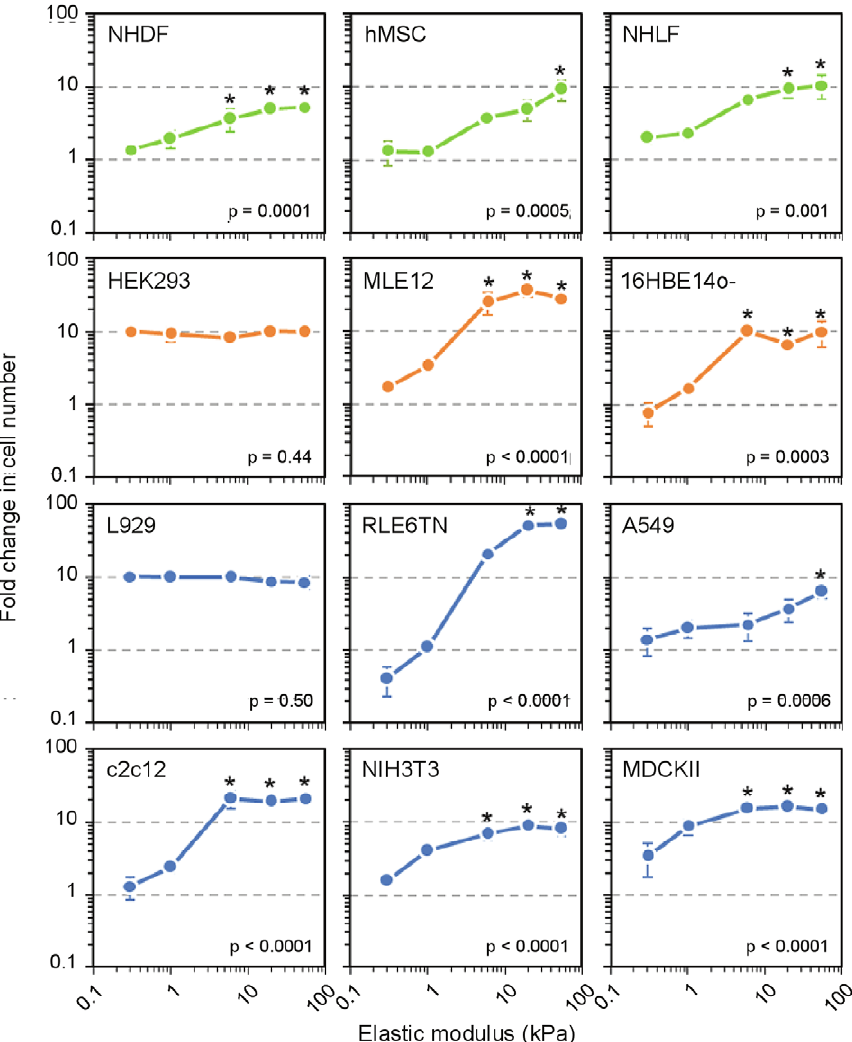
Figure 5. Stiffness-dependent growth profiles. 12 cell types ( Table 1 ) cultured across 5 stiffness conditions in 96 well plates. Fold change represents number of attached cells at 72 h versus the 4 h attachment density. Cells are classified as normal (green), SV40- or adenovirus-transformed (orange), or spontaneously immortalized (blue). Error bars indicate mean 6 SD (n=3). P values from one-way ANOVA are indicated in each plot. *p , 0.05 vs. growth on the softest substrate (0.3 kPa) by Tukey’s test.